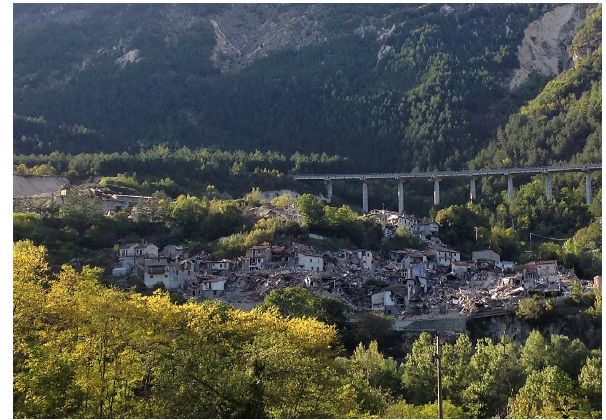
Figure 10. The town of Pescara del Tronto, which was razed by the earthquake of 24 August